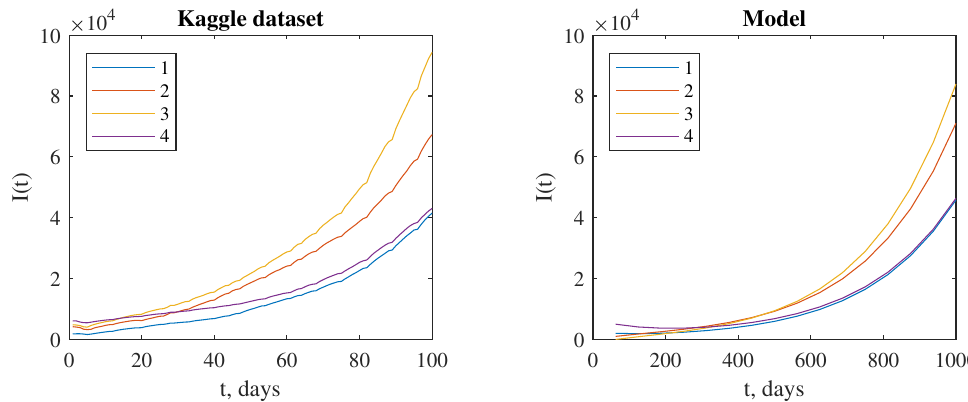
Figure 5. The dynamics of the infection cases in the prefectures and districts (Tokushima—1, Kagawa—2, Ehime—3, Kochi—4) for the Kaggle dataset and model data with the parameters n = 2.8 · 10 6 , β = 8.5, γ = 3.5, δ = 1.5, b = 0.01, d = 10 − 7